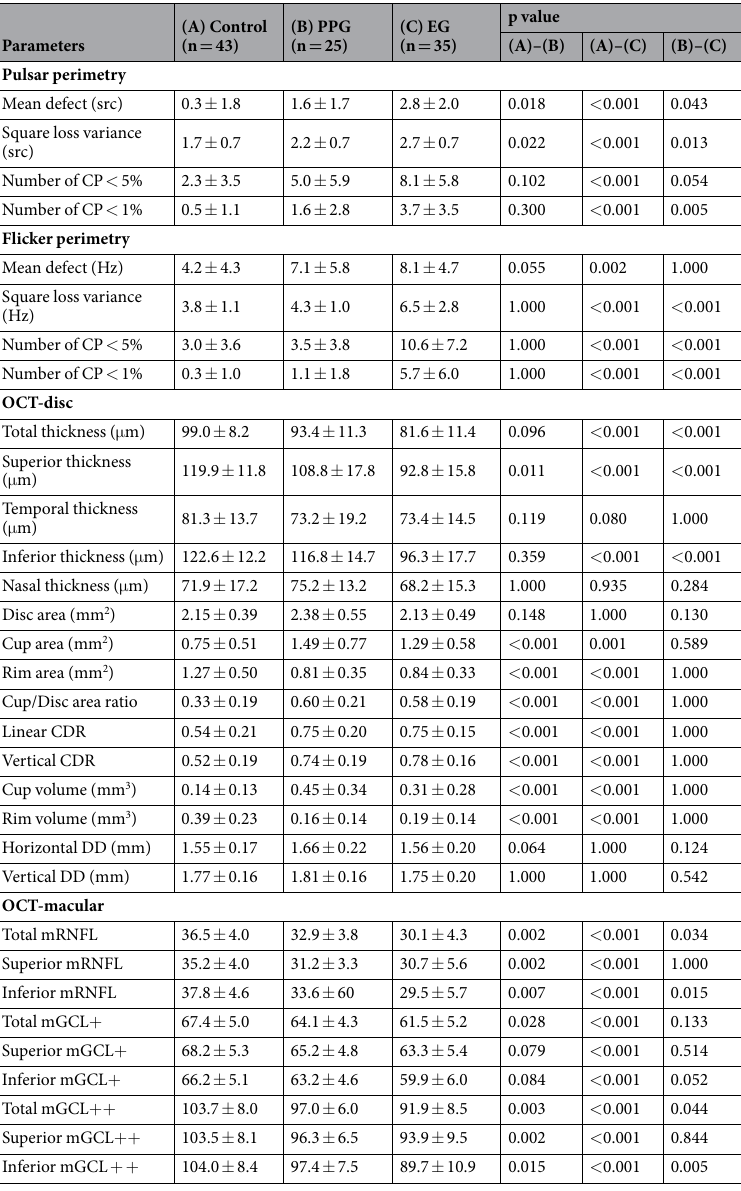
Table 2. Comparison of each parameter measured with Pulsar, Flicker, and SD-OCT. PPG = pre-perimetric glaucoma; EG = early glaucoma; CP = corrected probability; OCT = optical coherence tomography; CDR = cup to disc ratio; DD = disc diameter; mRNFL = macular retinal nerve fiber layer; mGCL = macular ganglion cell layer and inner plexiform layer; mGCL + + = mRNFL and mGGCL. Data are expressed as mean ± standard deviation. Statistical comparison was performed with a Bonferroni